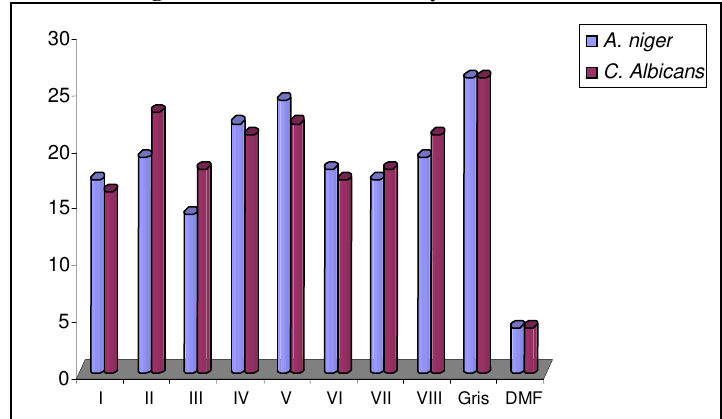
Figure 4. .Antibacterial activity of Schiff bases.